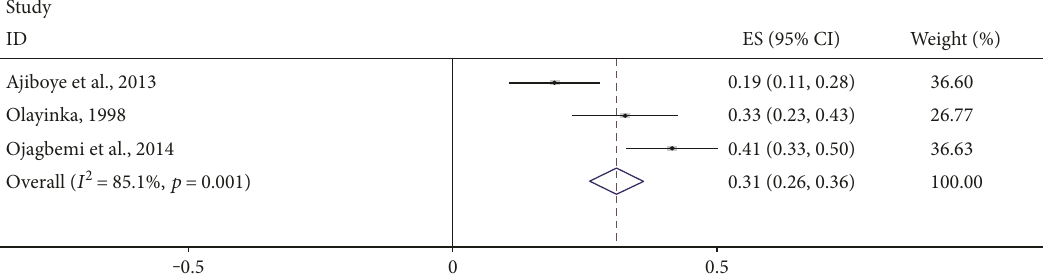
Figure 2: Forest plot showing the pooled prevalence of clinically diagnosed poststroke depression in sub-Saharan Africa.